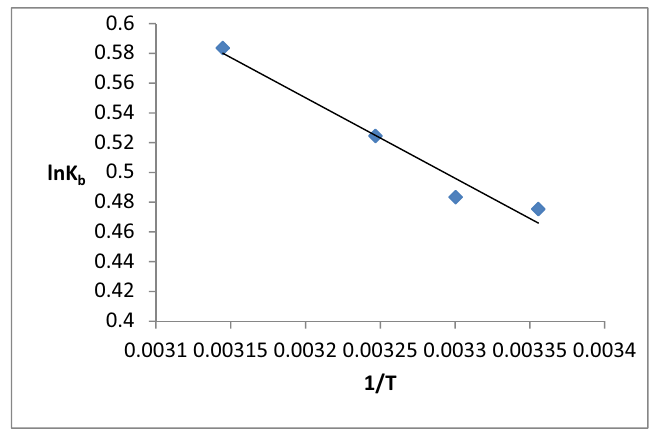
Figure 8. Van’t Hoff plot for binding of BSA with MiADMSA.